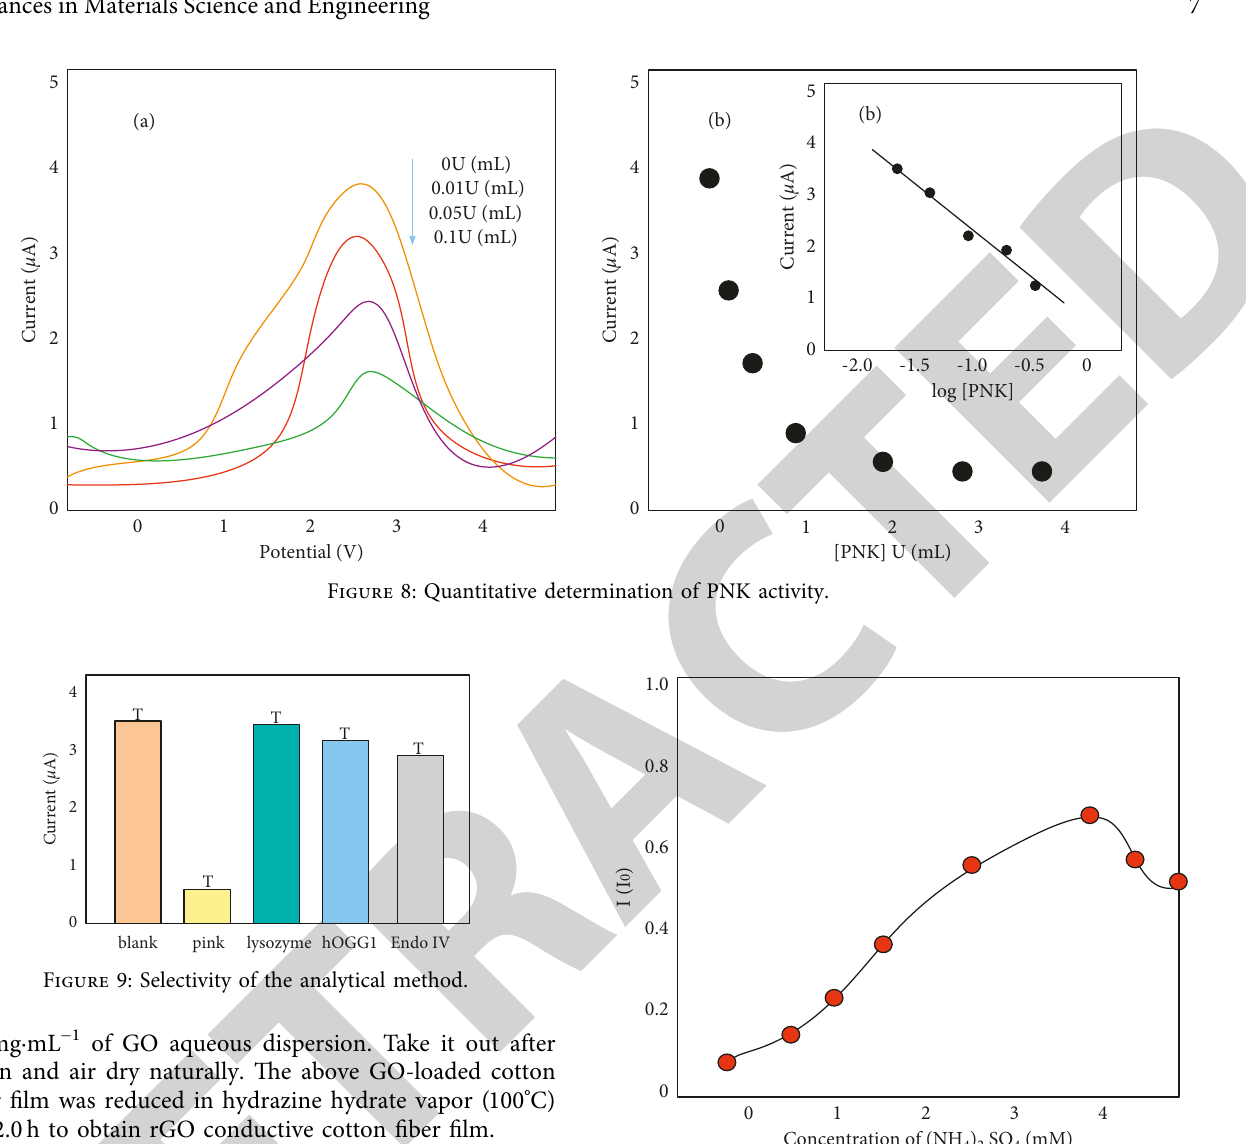
Figure 10: The effect of ammonium sulfate on PNK